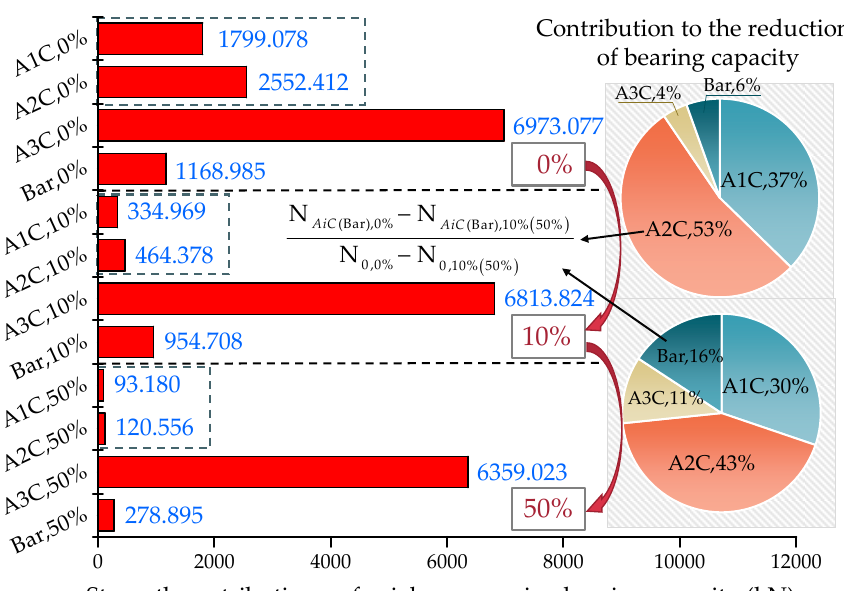
Figure 8. The strength contributions of axial compression bearing capacity.